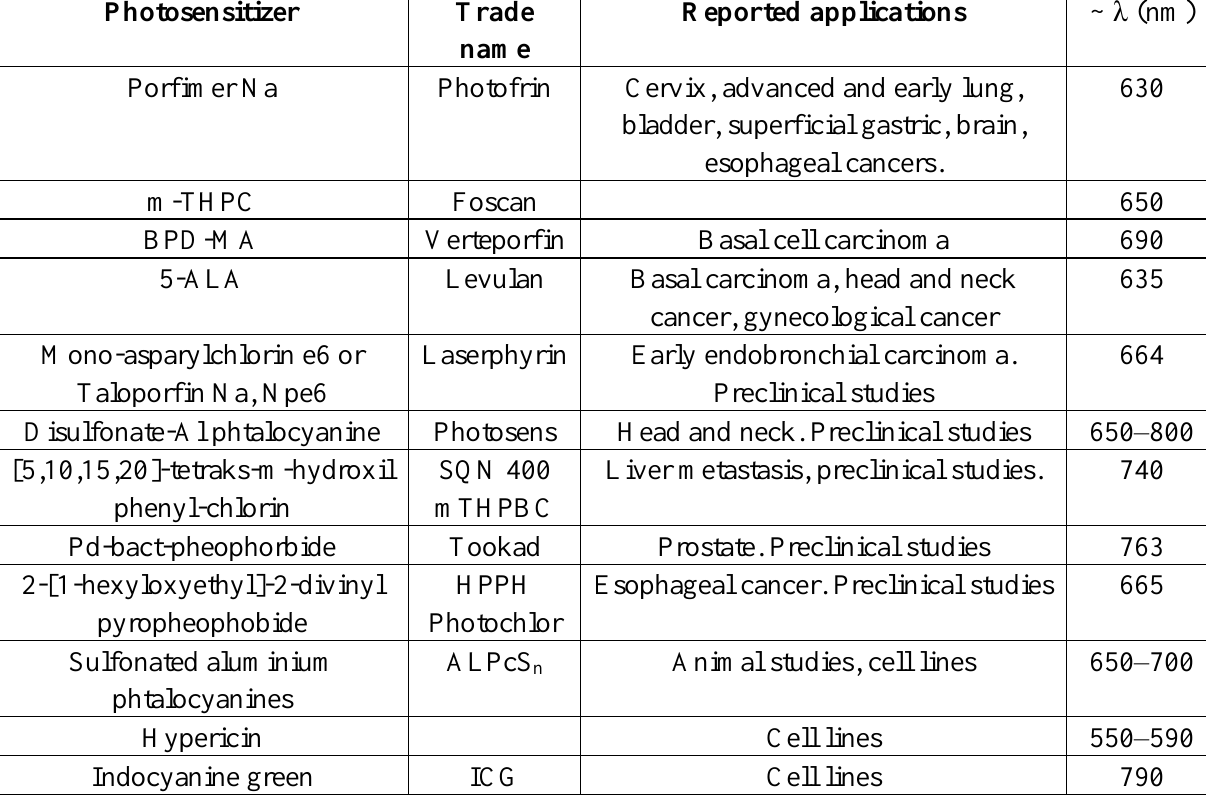
Table 1. Photosensitizers commonly used in in vitro and in vivo